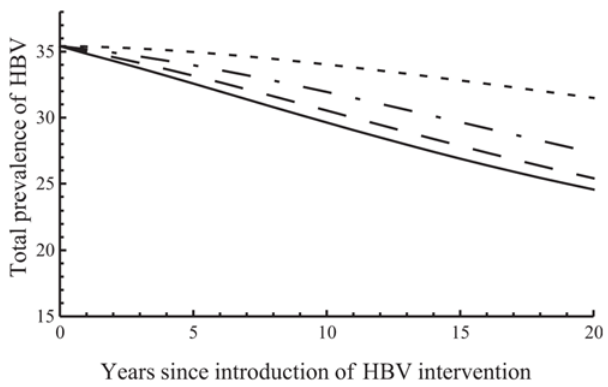
Figure 6. The initial impact of treatment on the prevalence of hepatitis B (HBV). Antiviral treatment reduces infectivity of chronic HBV by 20%. The total prevalence of HBV is shown as percentage of the population. When the intervention is introduced (year 0), 36% of the population is infected with HBV; among them, the percentage coinfected with hepatitis D is 30% (solid line), 20% (dashed line), 10% (dashed-dotted line), or 0% (dotted line).